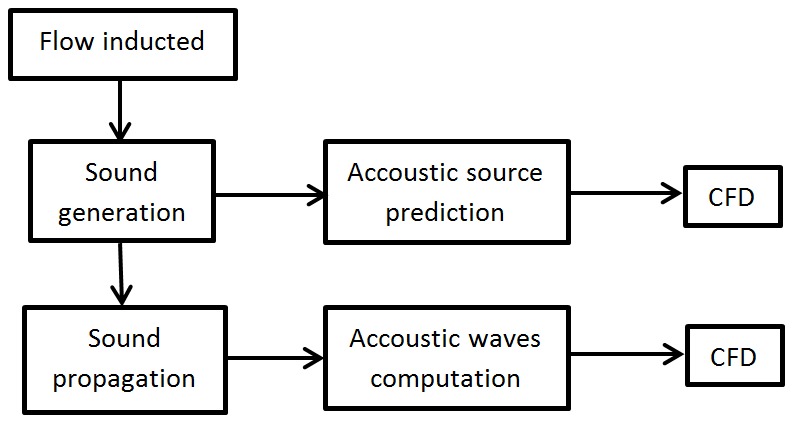
Overview of the CFD for acoustics of wind turbine.